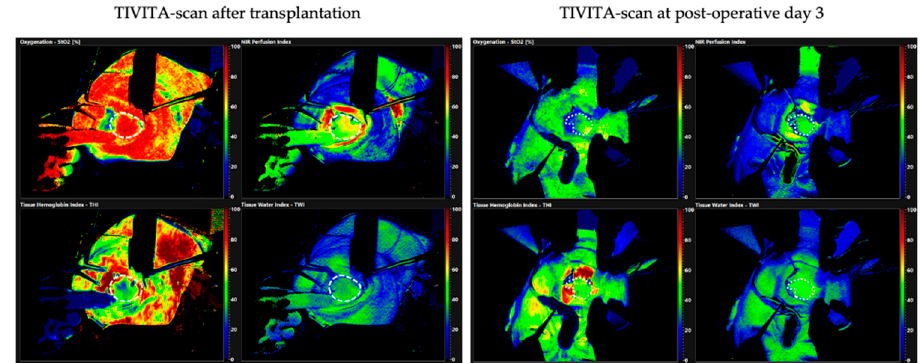
Figure 8. A TIVITA scan immediately after transplantation of the RFFF into the floor of the mouth is shown on the left. The circular mark (white dotted line) indicates the graft inside the patient’s mouth. The measurement shows a (typical) initially very high oxygenation of the graft with correspondingly high NIR values and adequately low THI values. In the course of time, up to postoperative day 3 shown on the right, a reduction of the StO 2 and NIR values and a homogenization of the measured values over the area of the graft are visible. Based on previous studies [21], it could be determined that this process is typical for the proper healing and perfusion of the graft.